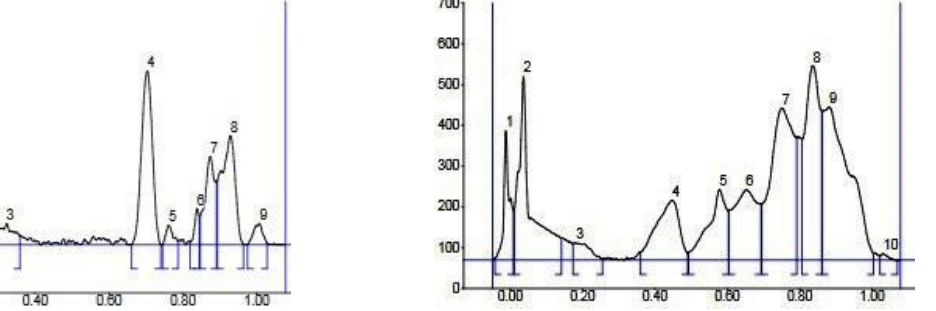
Fig. 21. Reflux - ethyl acetate fruit Fig. 22. Reflux - methanol extraction Table 5. HPTLC analysis of soxhalated hexane fruit extract Peak